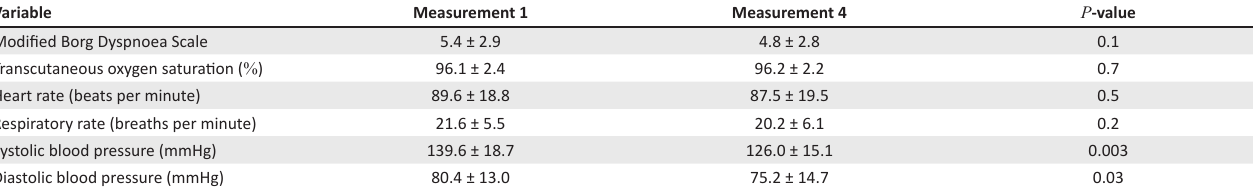
TABLE 4: Changes in secondary outcome measures between baseline (measurement 1) and the final measurement (measurement 4).